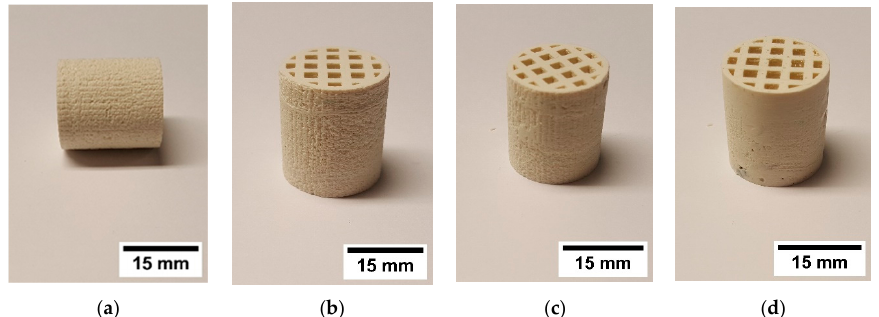
Figure 15. Green honeycombs additively manufactured with different suspensions: ( a ) C&G, ( b ) C&G, ( c ) C&G, and ( d ) A&F. ( c ) C&G, and ( d ) A&F. C&G, ( c ) C&G, and ( d ) A&F.